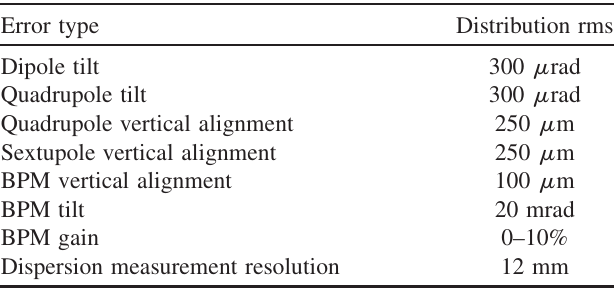
TABLE I. The rms values for error